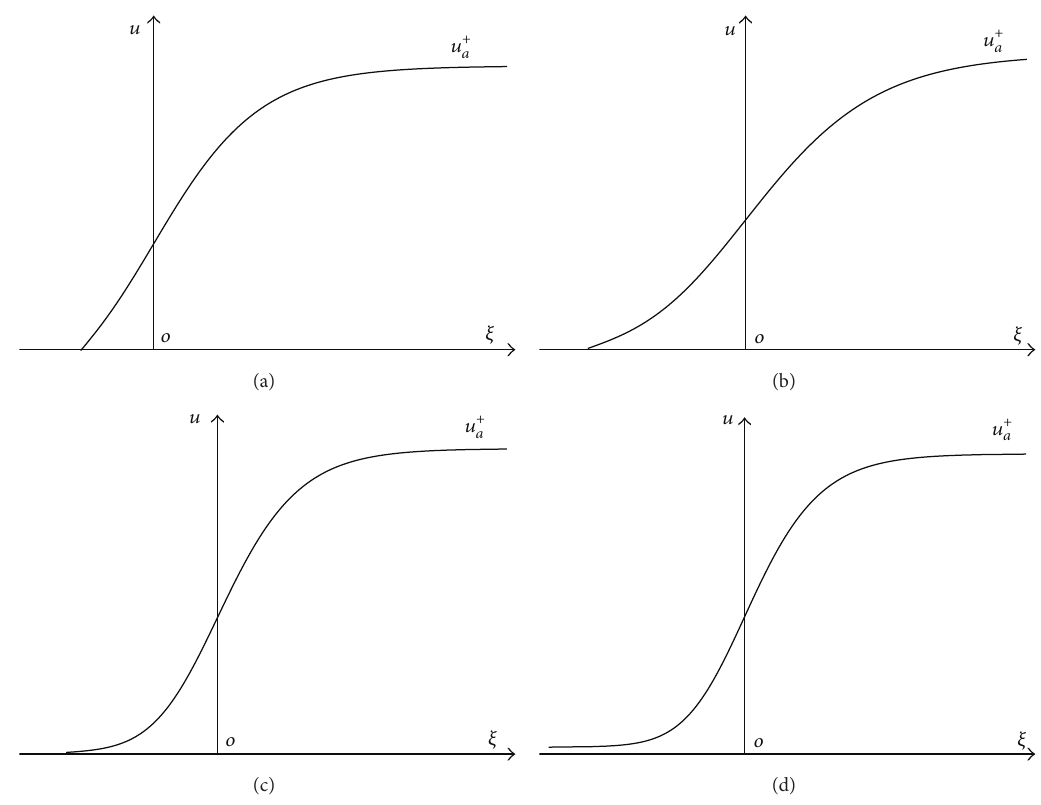
Figure 14: (The kink wave is bifurcated from the kink-like wave). The varying process for the graph of 𝑢 + 𝑎 when 𝑐 > 0 , 𝛿 > 0 , 𝑎 > 0 , and 𝑏 → −16𝑎 2 /75𝑐 + 0 , where 𝑐 = 1 , 𝛿 = 1 , 𝑎 = 1/2 , and (a) 𝑏 = −16𝑎 2 /75𝑐 + 10 −3 . (b) 𝑏 = −16𝑎 2 /75𝑐 + 10 −4 . (c) 𝑏 = −16𝑎 2 /75𝑐 + 10 −6 . (d) 𝑏 = −16𝑎 2 /75𝑐 + 10 −8